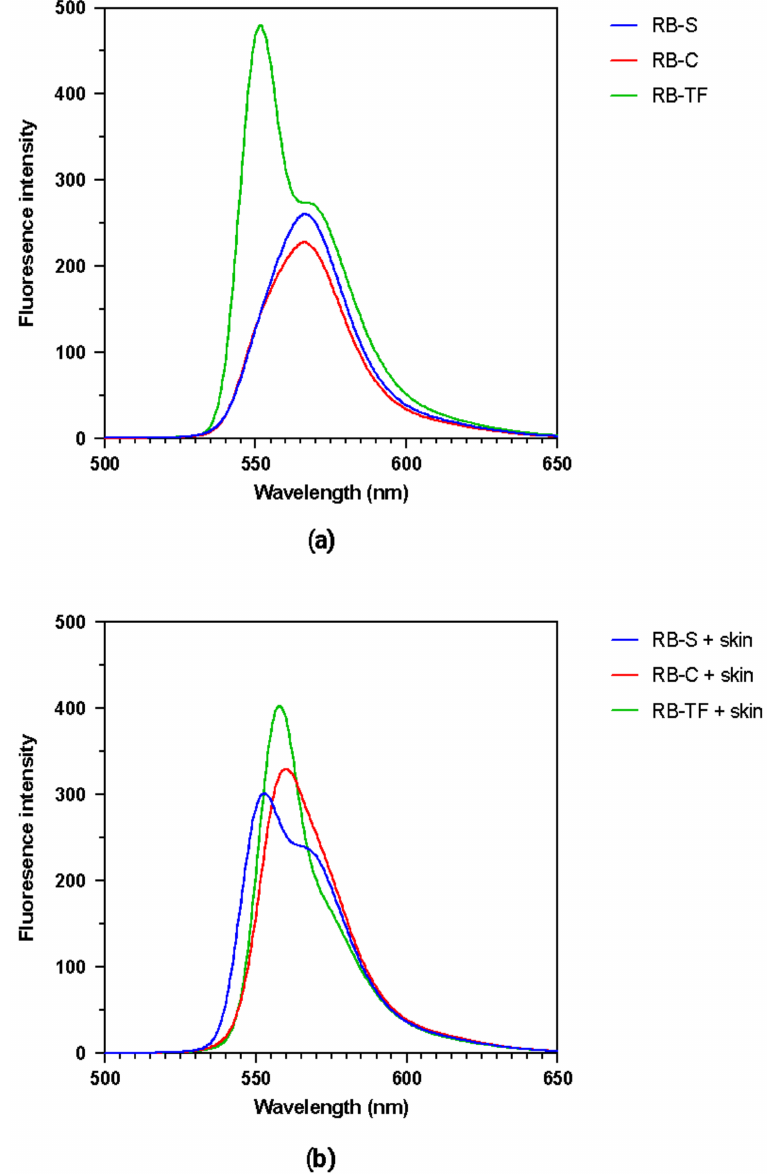
Figure 9. Fluorescence spectra of RB in different environments. ( a ) RB solution (RB-S), RB-loaded aqueous cream BP (RB-C) and RB-TF dispersion. Samples were diluted with PBS, and the auto zero was performed using blank PBS. ( b ) Samples were obtained from skin spiked with RB-S, RB-C and RB-TF. The auto zero was performed using a sample obtained from blank